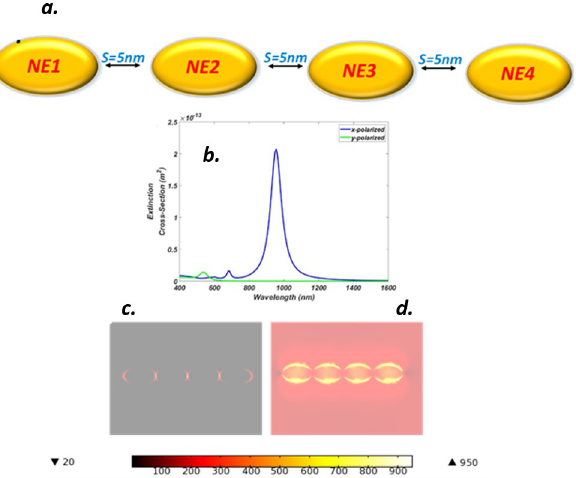
Fig 8. (a) Truncated Gold linear chain nano-elliptical quadramer (LCNEQ) with gain media coating and separation S = 5 nm (b) ECS of LCNEQ for x-y luminance (c) NFE of LCNEQ for x-polarization (d) NFE of LCNEQ for y-